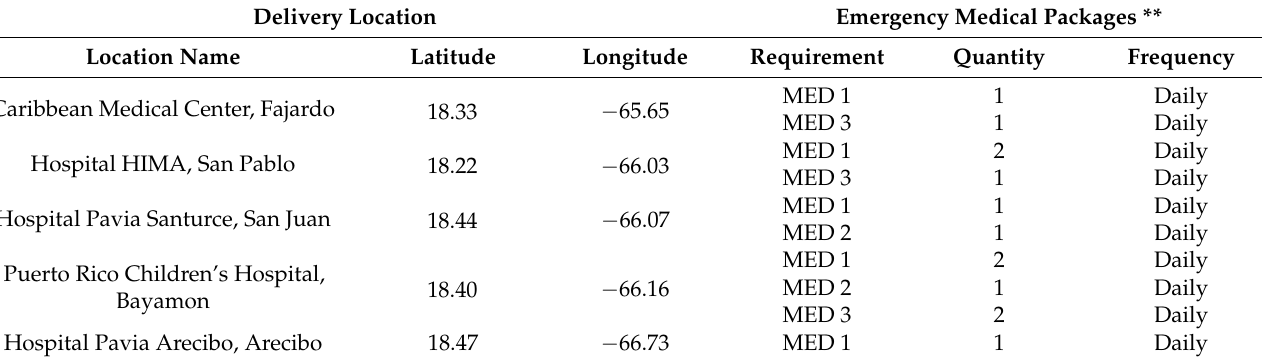
Table 6. Anticipated Medical Package